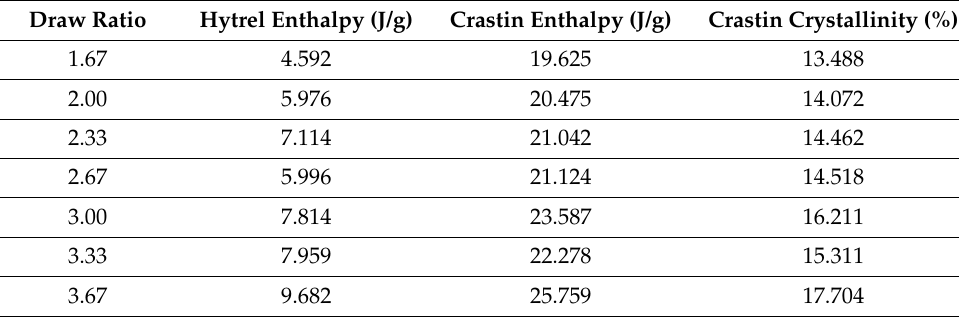
Table 2. Enthalpies for Hytrel and Crastin Components in Bicomponent Fibers. Draw